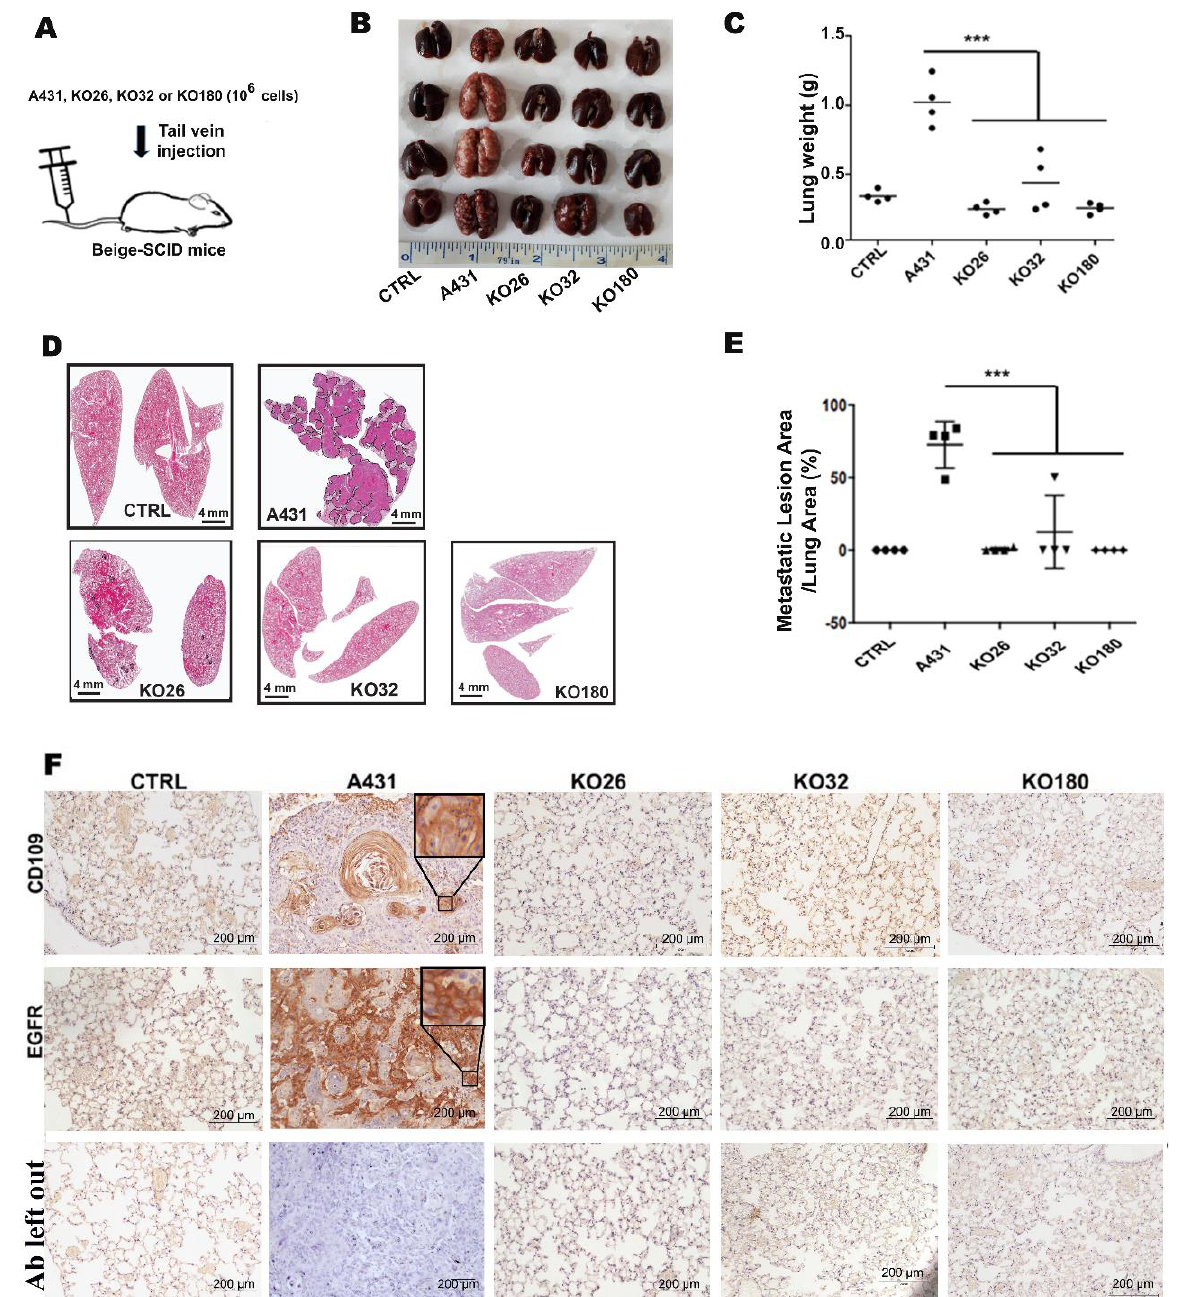
Figure 2. The loss of CD109 diminishes lung metastasis of SCC cells in vivo. ( A ): Experimental design of lung metastasis via tail vein assay. ( B ): Representative macroscopic images of lung metastases in formalin-fixed organs. ( C ): Quantification of lung weights in mice injected via tail vein with PBS control, A431 control cells, and three CD109 KO A431 cell lines as indicated. ( D ): Representative images of H&E-stained sections of lung tissues and lung metastases shown in B. ( E ): Quantification of lung tumor lesions in PBS control or A431 and three CD109 KO cells. All the results are expressed as the mean ± S.D. Significance was calculated using a One-Way ANOVA *** p < 0.001. ( F ): IHC staining for CD109 (top row), EGFR (middle row), and primary antibody left out control (bottom row) in the lung sections of mice injected with PBS (control), A431 control cells, KO180 A431, KO32 A431, or KO26 A431 cells.